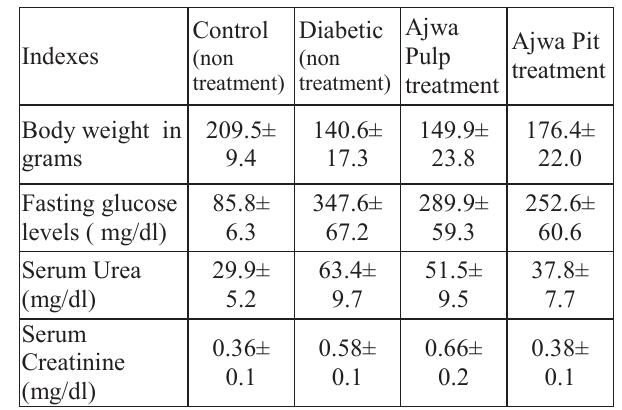
Table-1: Results for body weight, fasting blood glucose & serum urea at 4 weeks